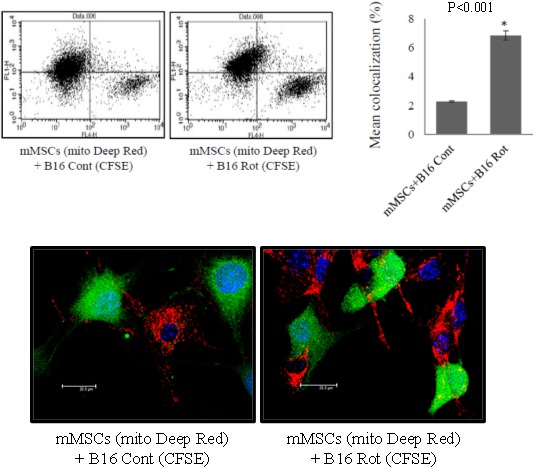
CFSE labeled B16 cells were co-cultured with mitoDR labeled MSC for 24 h.In identical experiments the B16 cells were pretreated with rotenone to induce mitochondrial dysfunction. Double positive cells were counted by FACS and also visualized on microscopy. Rotenone pre-treatment of B16 led to greater mitochondrial transfer and increase in double positive cells from about 2% to 7%. The geometric mean intensity of double positive cells also in-creased suggesting greater transfer.